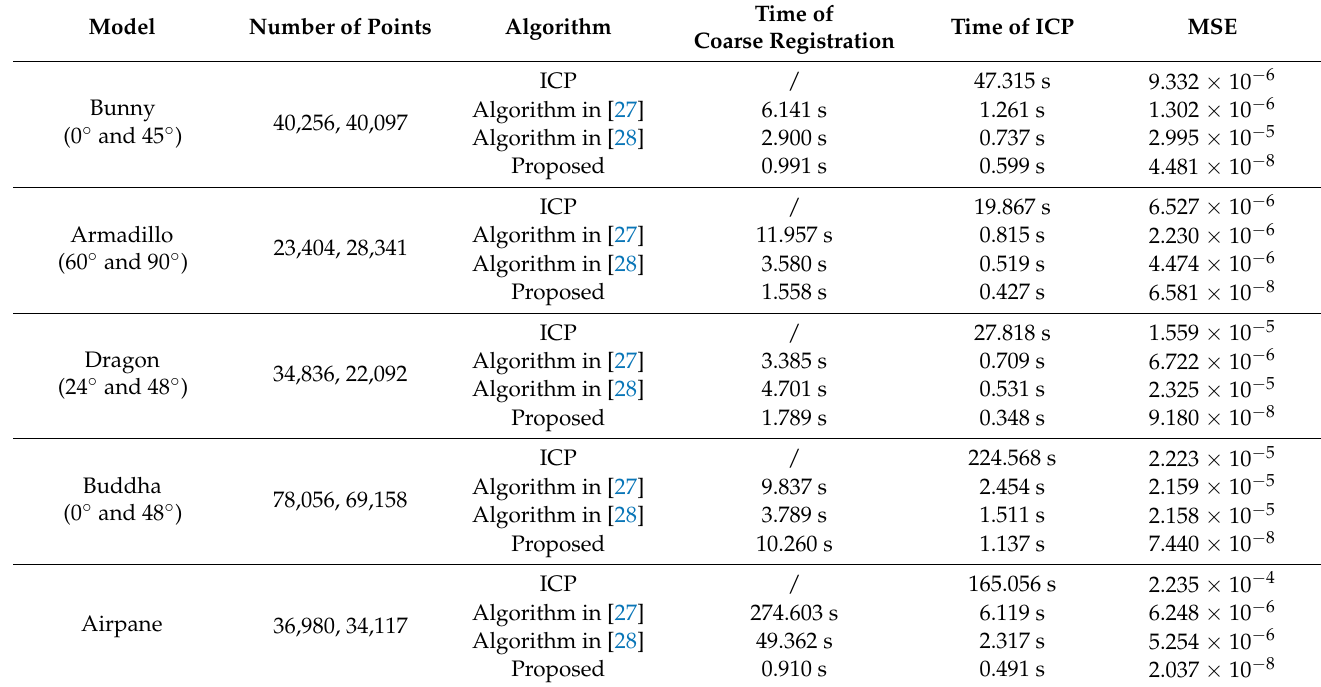
Table 4. Registration results of different angles.